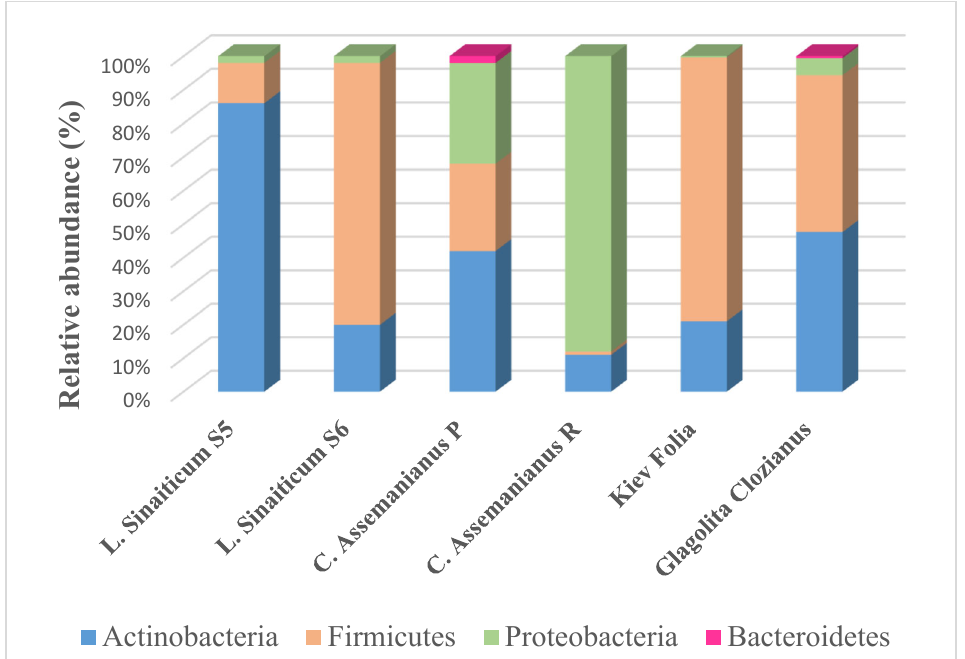
Figure 6. Shotgun metagenomics showing the relative abundance (%) of bacterial phyla in the microbiomes of ancient Slavonic codices [3,8] (and Glagolita Clozianus in this study).